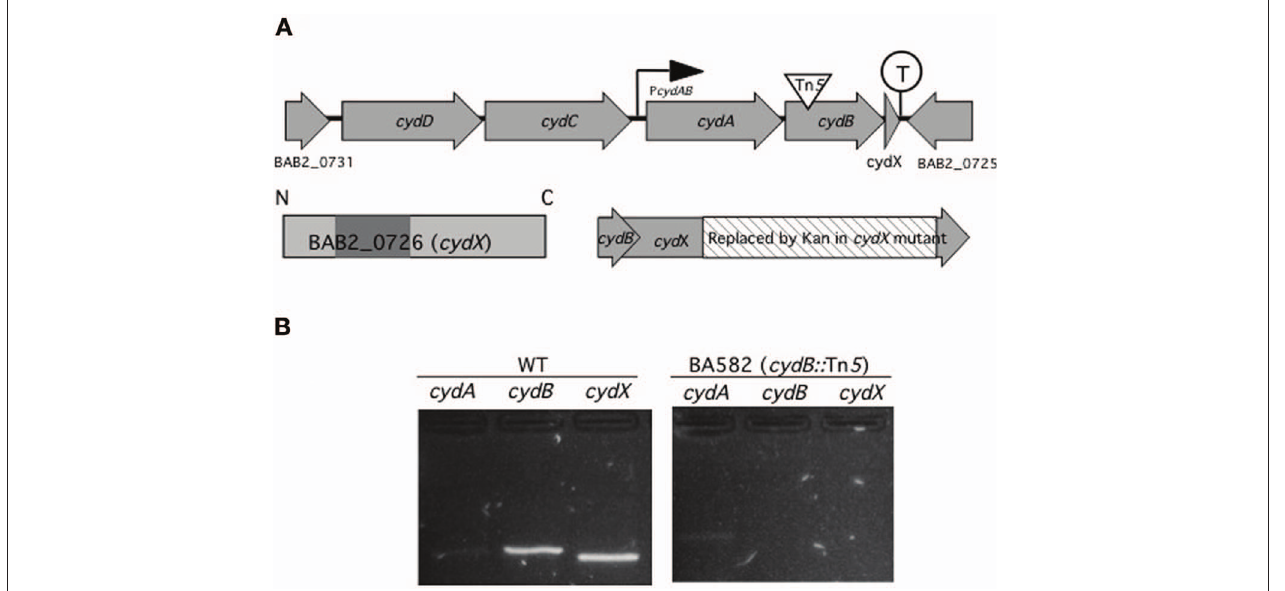
terminator (circled T) is located between cydX and its adjacent open reading frame BAB2_0725. In BA582 ( cydB ::Tn 5 ) a transposon is inserted in cydB (triangle) while in cydX ::Kan part of cydX (hatched) is replaced by a kanamycin resistance determinant without disrupting cydB . (B) Analysis of the cyd gene cluster by RT-PCR. PCR products for the indicated primers with wild type (WT) or cydB ::Tn5 mutant (BA582) as a template are shown. The sizes of the predicted amplicons for cydA , cydB , and cydX are 247bp, 243bp, and 204bp, respectively. Control reactions in which reverse transcriptase were omitted had no amplification product (not